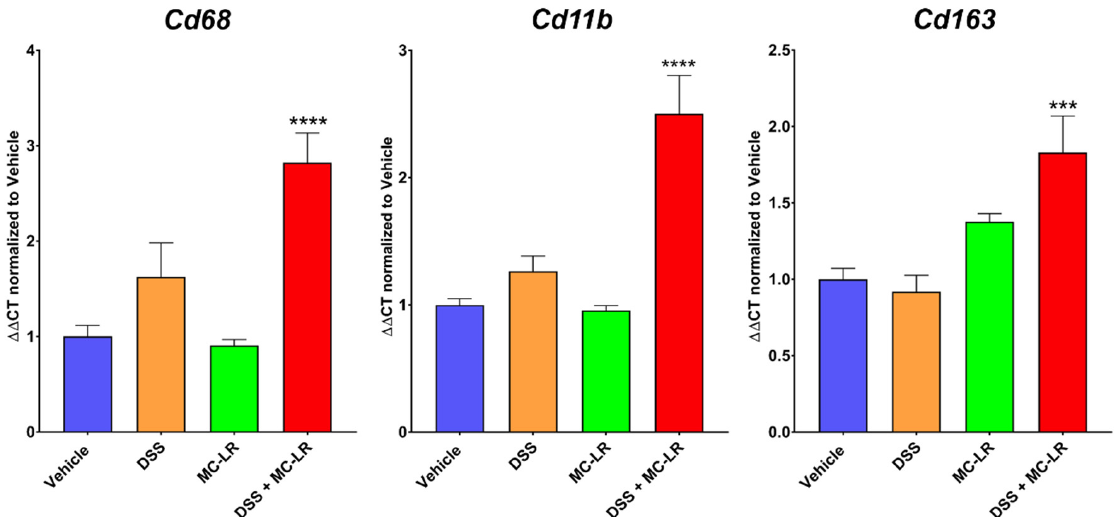
Figure 1. F4/80-positive macrophages in FFPE colonic sections of DSS-induced colitis model C57BL/6J mice. ( A ) IHC stain- ing in: (Vehicle) control animals without DSS-induced colitis or MC-LR exposure. (DSS) DSS-induced colitis without MC- LR exposure. (MC-LR) MC-LR exposed animals without DSS-induced colitis. (DSS + MC-LR) DSS-induced colitis with MC-LR exposure. Red arrows denote positive F4/80 staining of macrophages. ( B ) Quantification of F4/80-positive macro- phages by count in 10 random foci per animal (n = 3). Significance by one-way ANOVA ( p < 0.0001) and **** = p < 0.0001 by Tukey’s multiple comparisons test.